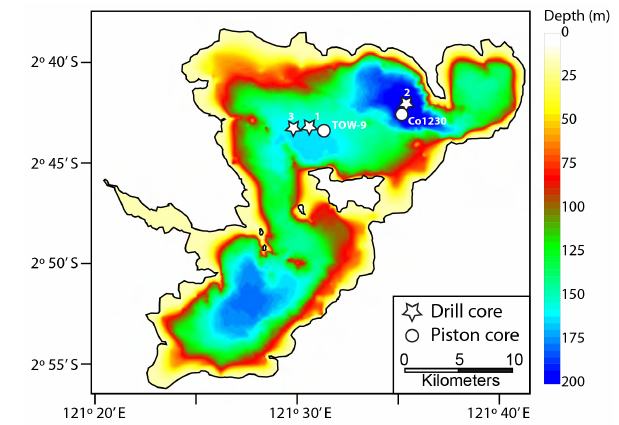
Figure 2. A bathymetric map of Lake Towuti showing the location of core sites discussed in the